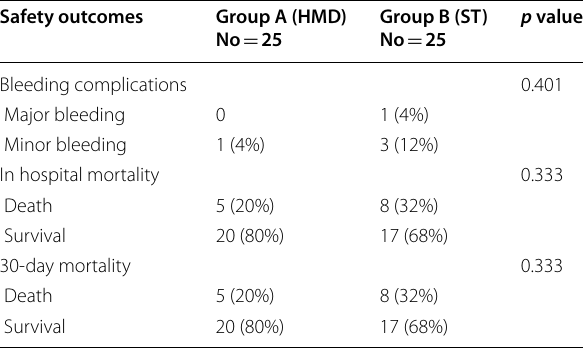
Data are presented as number and percent. HMD defragmentation; ST systemic thrombolysis; *Statistically significant difference = ( p <